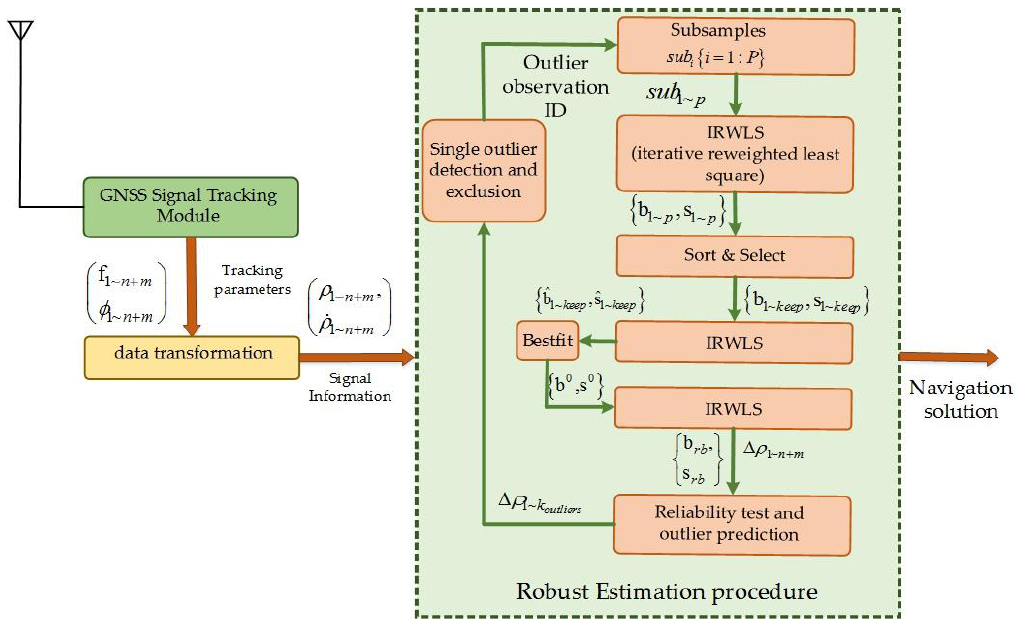
Figure 1. Implementation flowchart of proposed estimation scheme. Table 2. Software Receiver Specifications.